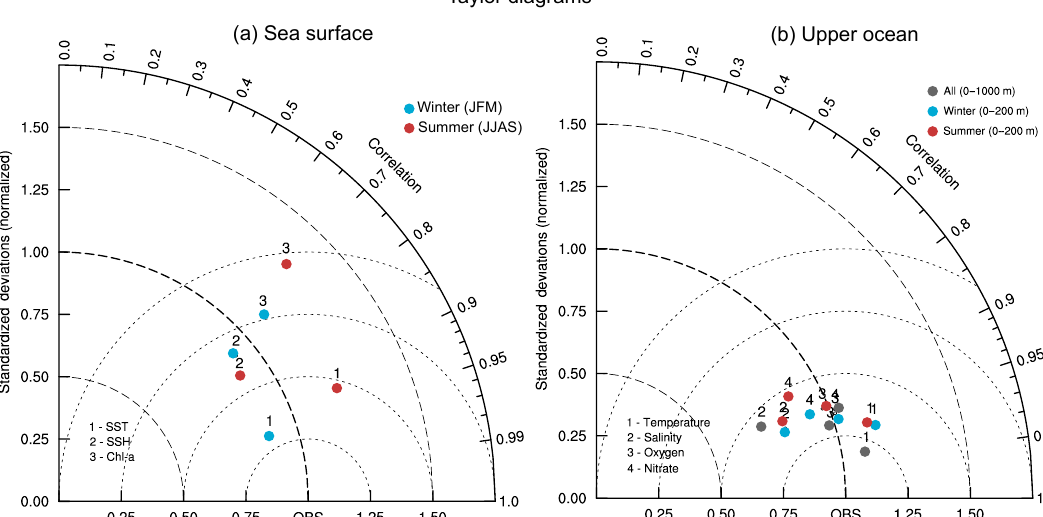
Figure 4. Taylor diagram displaying statistical comparison of modeled and observed fields. Taylor (2001) diagram of simulated (a) sea surface temperature (data points labeled “1”), sea surface height anomalies (data points labeled “2”) and surface chlorophyll a (data points labeled “3”) in winter (blue) and summer (red) months and (b) temperature (data points labeled “1”), salinity (data points labeled “2”), oxygen (data points labeled “3”) and nitrate (data points labeled “4”) in the upper 1000m and in the top 200m in winter (blue) and summer (red) months. The reference point of the Taylor diagram corresponds to (a) SeaWiFS observations for chlorophyll, AVHRR data for surface temperature and AVISO climatology for sea surface height anomalies and (b) World Ocean Database (2013) for all four variables. The radius (distance to the origin point) represents the modeled standard deviation relative to the standard deviation of the observations. The angle between the model point and the x axis indicates the correlation coefficient between the model and the observations. Finally, the distance from the reference point to a given modeled field represents that field’s centered rms with respect to